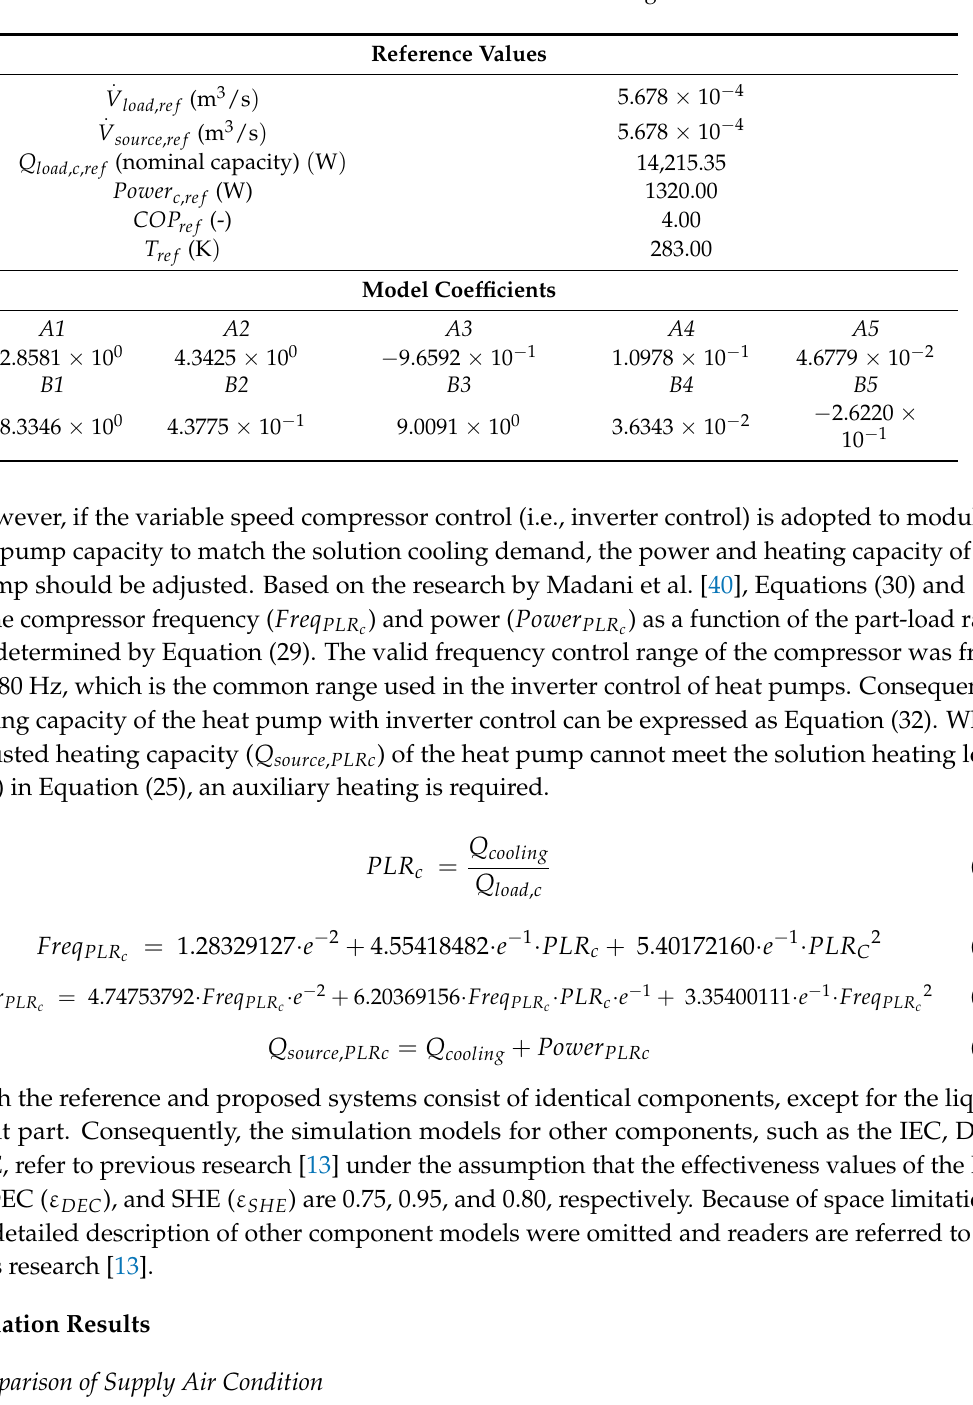
Table 4. References and coefficients for cooling